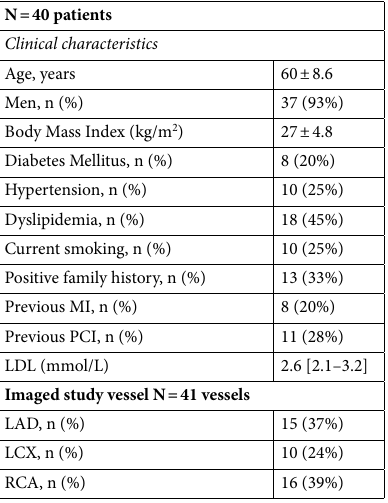
Table 1. Patient characteristics. MI myocardial infarction, PCI percutaneous coronary intervention, LDL low dense lipid protein, LAD left anterior descending, LCX left coronary circumflex, RCA right coronary artery.